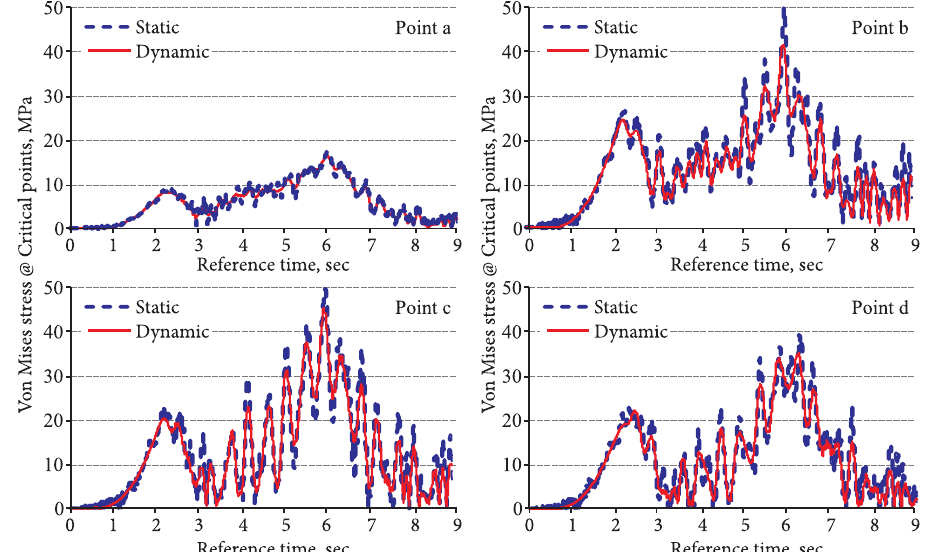
Fig. 8. Stress time history for critical